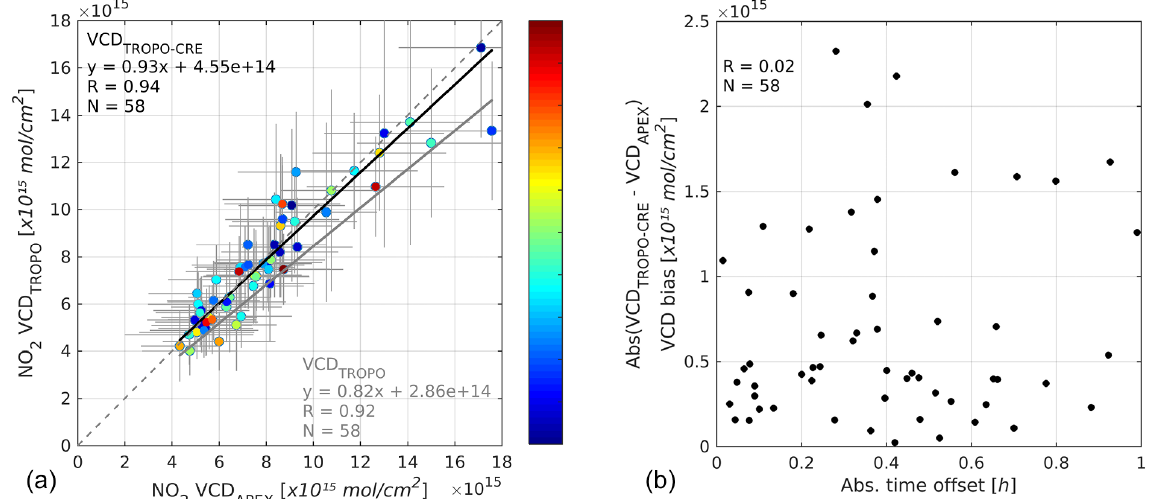
Figure 10. (a) Same as Fig. 8a, but data points are colour coded based on the absolute time offset between TROPOMI overpass and mean acquisition time of APEX retrievals within the TROPOMI pixel, and in panel (b) the observed NO 2 VCD bias, defined by VCD TROPO − CRE − VCD APEX , has been plotted against the absolute time offset.